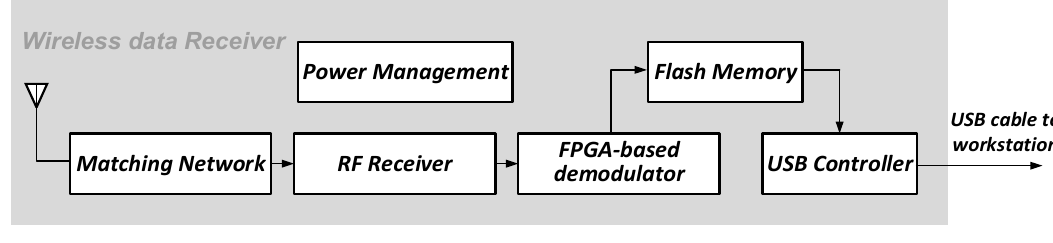
Figure 6. Block diagram of the data receiver.